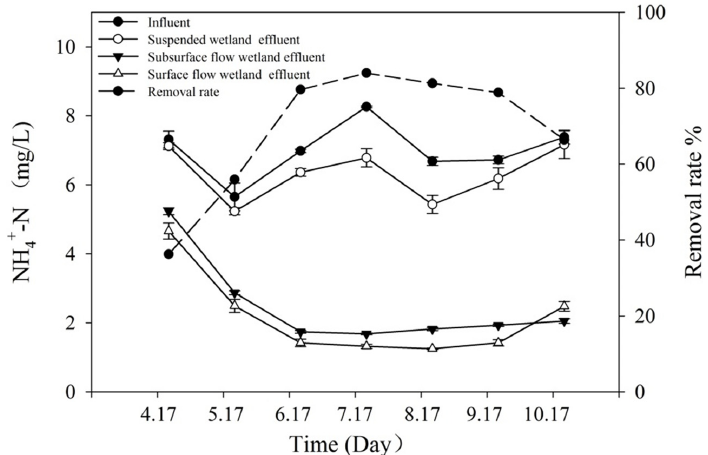
Figure 6. Concentration of NH 4+ -Nin the inflow and outflow and the removal rate.